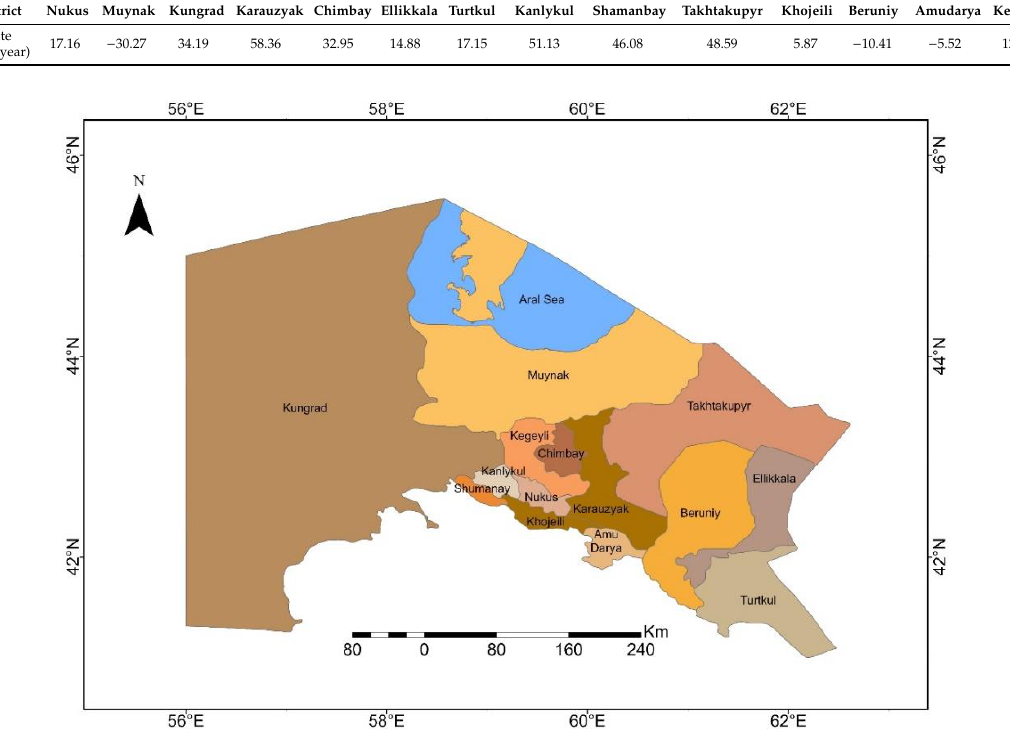
Figure 11. Administrative Map of Karakalpakstan.